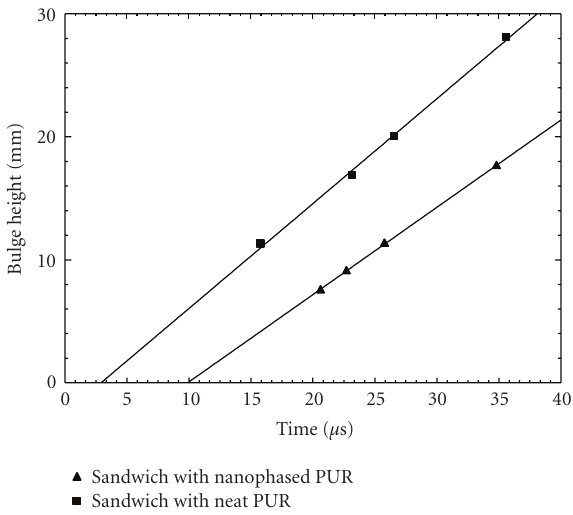
Figure 8: Bulge height versus time for sandwiches with both neat and nanophased polyurethane